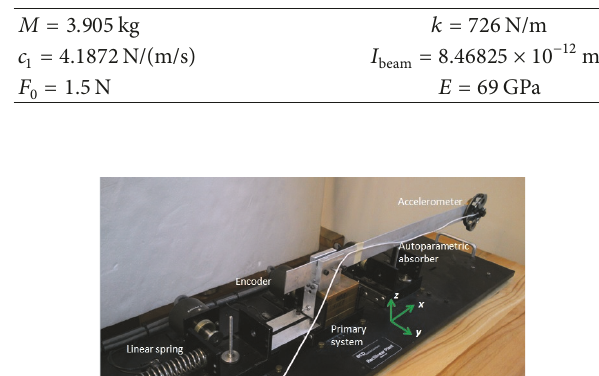
Table 3: Experimental system parameters.